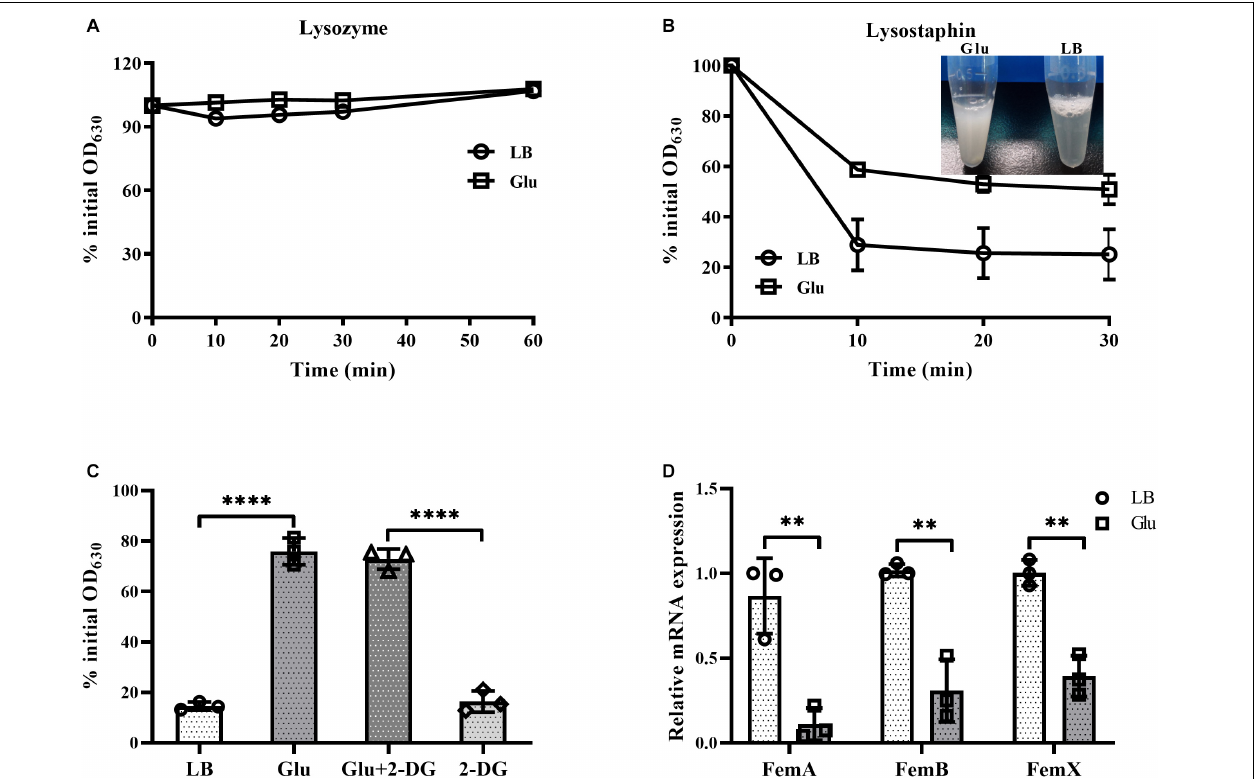
FIGURE 5 | Glucose reduced expression of pentaglycine. S. aureus Newman was cultured in LB medium with or without 15 mM glucose for 24 h. Bacterial cells were collected by centrifugation and resuspended in PBS buffer, with lysozyme (A) or lysostaphin (B) added at a final concentration of 50 and 10 µ g/mL, respectively. OD 630 measurements were taken at timed intervals. (C) Lysostaphin resistance of S. aureus Newman in medium supplemented with 15 mM glucose was unaffected by the addition of 60 mM 2-DG. (D) S. aureus Newman was cultured in LB medium with or without 15 mM glucose for 6 h, and bacterial cells were collected for analysis of mRNA expression of femA , femB , and femX . ∗∗ p < 0.01; ∗∗∗∗ p <